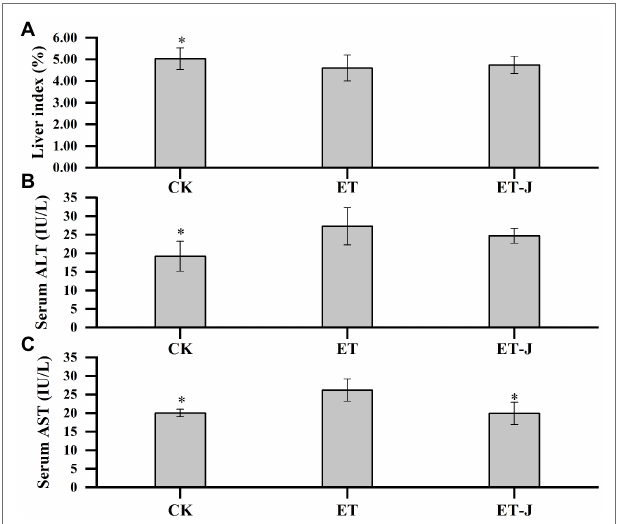
FIGURE 4 | Effects of fermentation broth on the contents of (A) lipopolysaccharide (LPS) and (B) inflammatory factors interleukin-6 (IL-6), and (C) Tumor necrosis factor- α (TNF- α ) in serum of ALD model mice. CK, mice were administrated with 0.9% normal saline; ET, mice were administrated with liquor; and ET-J, mice were administrated with liquor and fermentation broth (0.1 ml/10 g). Results are expressed as the mean ± SD ( n = 14). * p < 0.05 vs. ET; ** p < 0.01 vs.